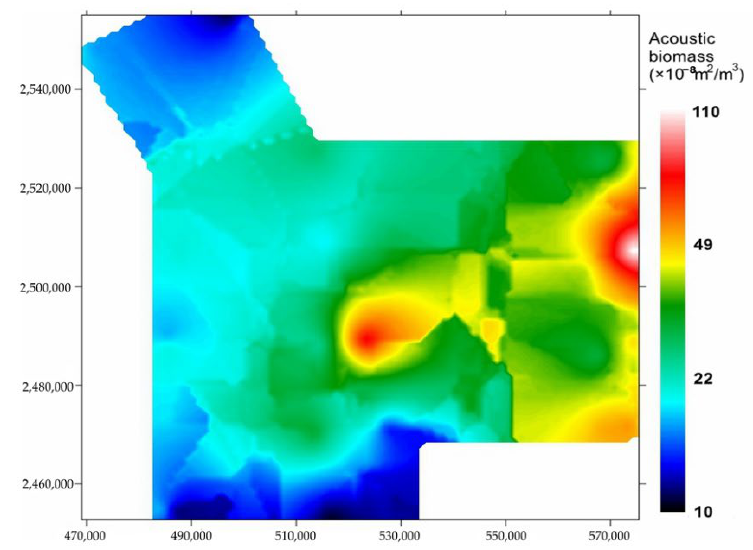
Figure 4. Spatial interpolation of fish density and acoustic biomass.